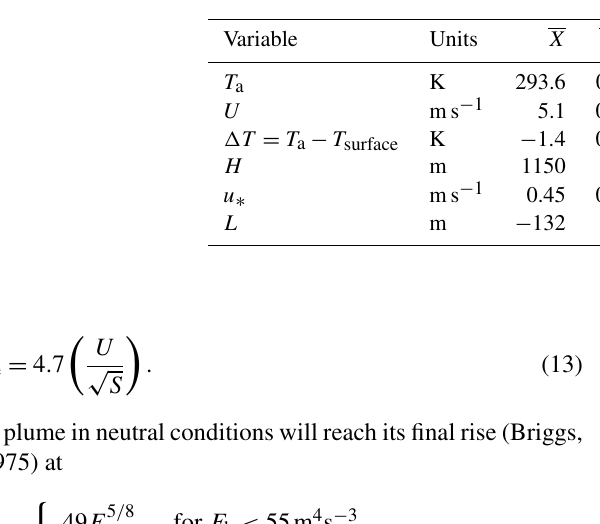
Table 5. Percentage changes in average plume height ( (cid:49)h(( 1 ± R)X)/(cid:49)h(X) ), where X is the modified parameter (i.e. T a , U , etc.). X is the average of each variable from the two tower measurements (AMS03 and AMS05) and (cid:49)X is the average difference. The “Low” value is the average change in plume rise calculated with ( 1 − R)X and the “High” value is the average change in plume rise calculated with ( 1 + R)X . All averages are for the 46 flight hours (box and screen flight times) and eight stacks used in the